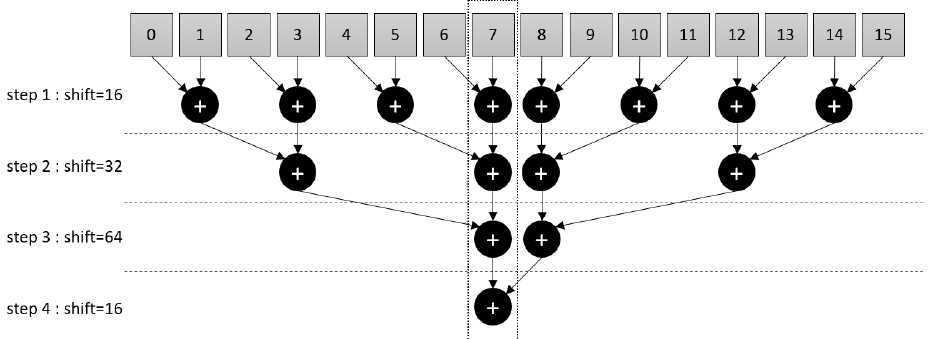
Figure 4. The addition tree execution steps for a row of sixteen MPX-p. Numbered grey squares correspond to MPX-p in a row of the MPA. Arrows converging on addition symbols (within a black circle) show how data from these MPX-p are summed together spatially. After four branches of the tree, the final results converge at the central MPX-p column (here MPX number 7). The communication shift value is specified for each branch at the left-hand side of the